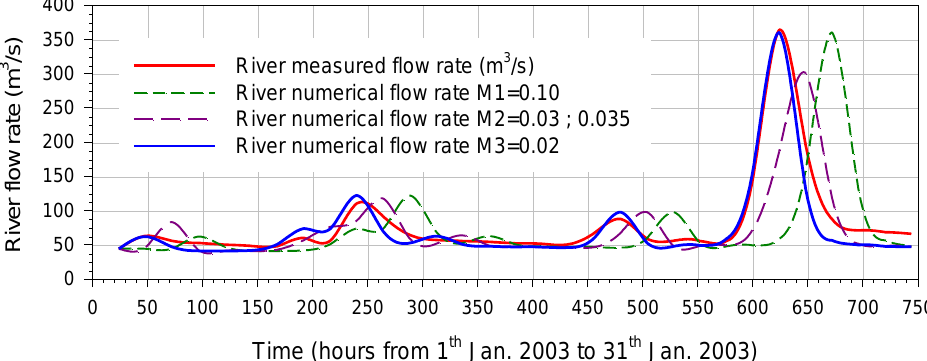
Figure 5. Comparison plots between measured and numerical river flow rate at Pescara S. Teresa Station; river measured river flow rate (m 3 /s): red line; river numerical flow rate (m 3 /s) resulting from simulations obtained by selecting different Manning’s coefficients: M1 = 0.1 (green short dashed line), M2 = 0.035 and M2 = 0.03, respectively, within the main drainage area surrounding the riverbed path and within the rest of the basin (dark pink, medium dash line), M3 = 0.02 (blue solid line).